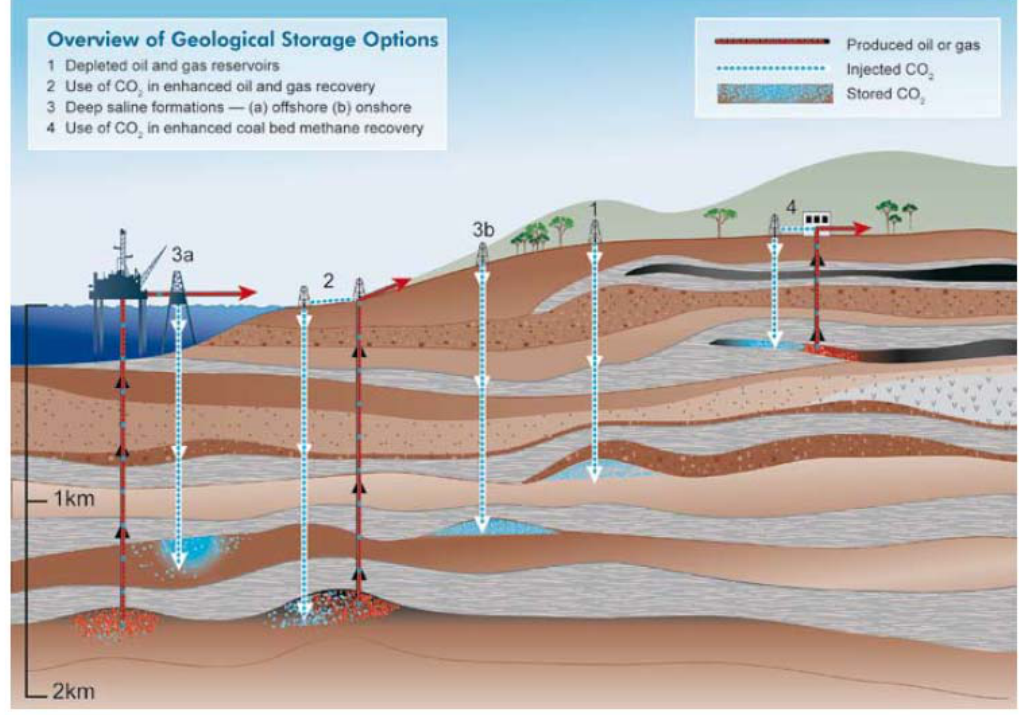
Figure 12. Geological storage options (after